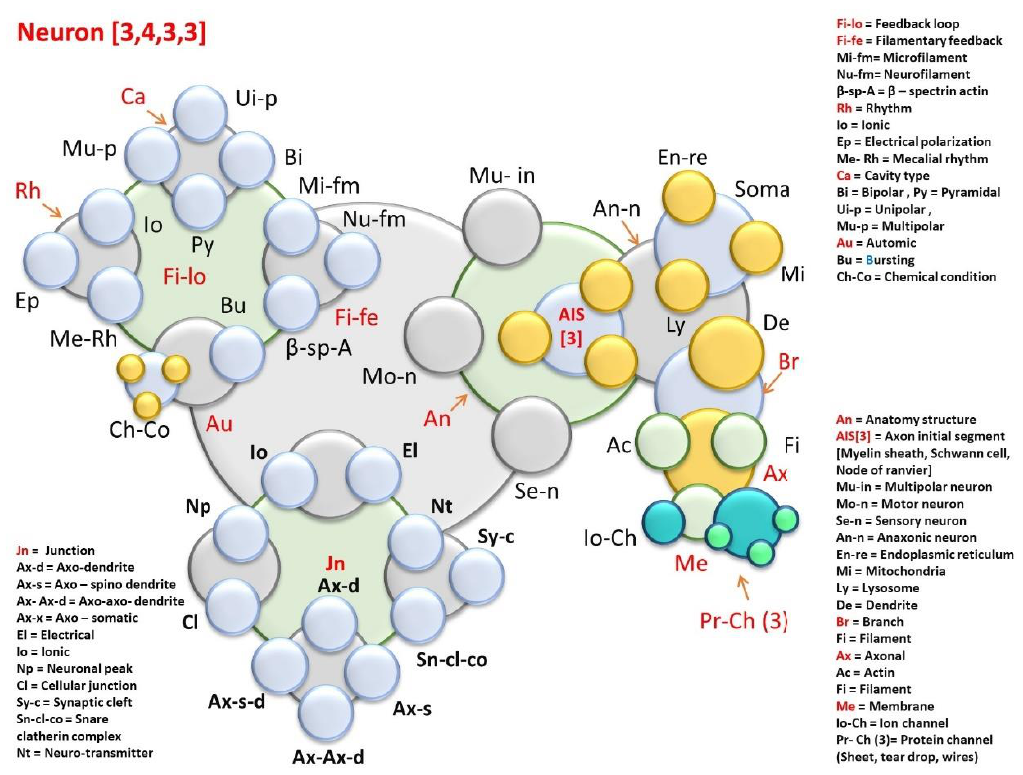
Figure 8. 2D clock architecture or time crystal representation of the cortex domain of the brain [41]. Information 2020 , 11 , x FOR PEER REVIEW